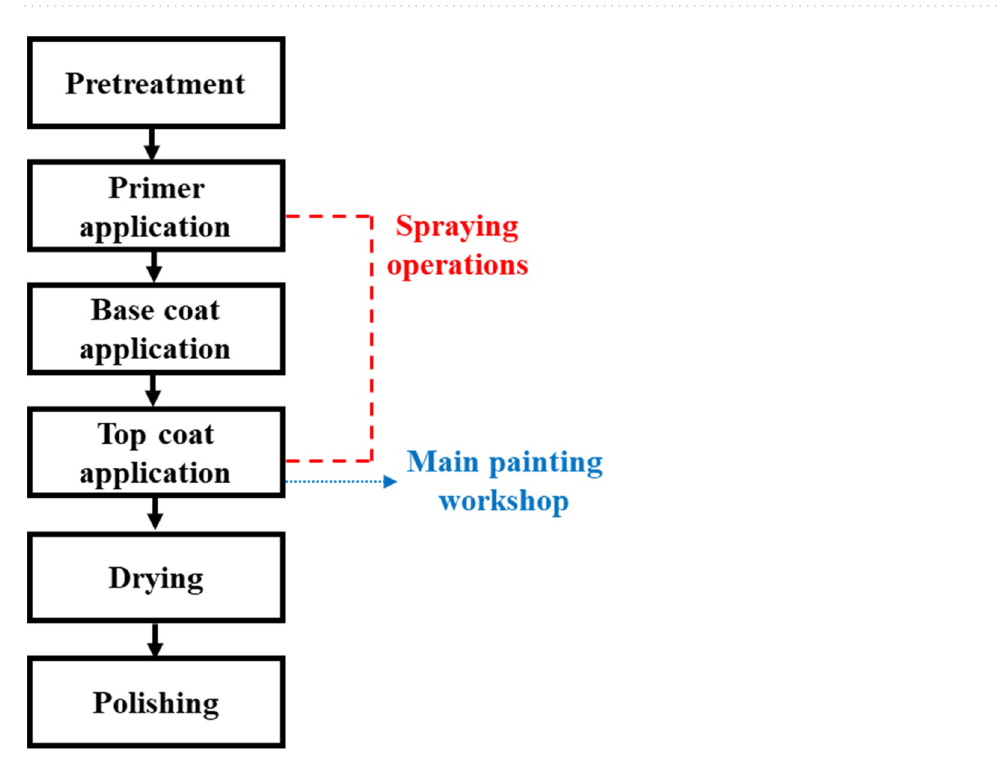
Figure 5. Flow chart outlining the auto-repair painting